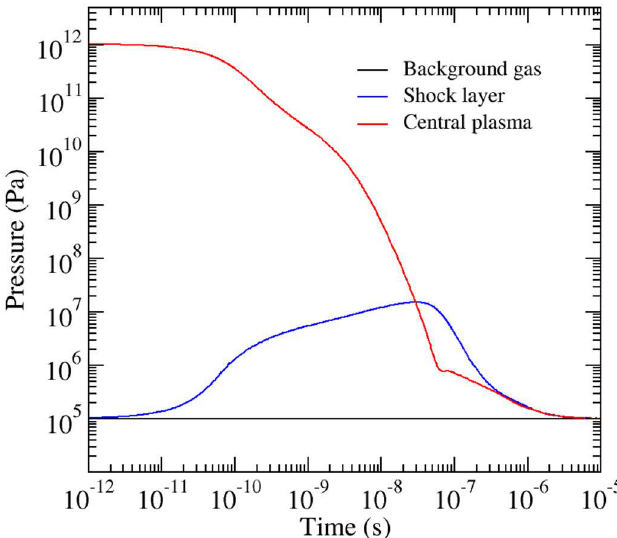
Figure 7. Evolution of the pressure inside the central tungsten plasma and inside the shock layer (case of argon) for a classical laser (10 mJ, 30 ps, 532 nm)-induced plasma experiment at atmospheric pressure.